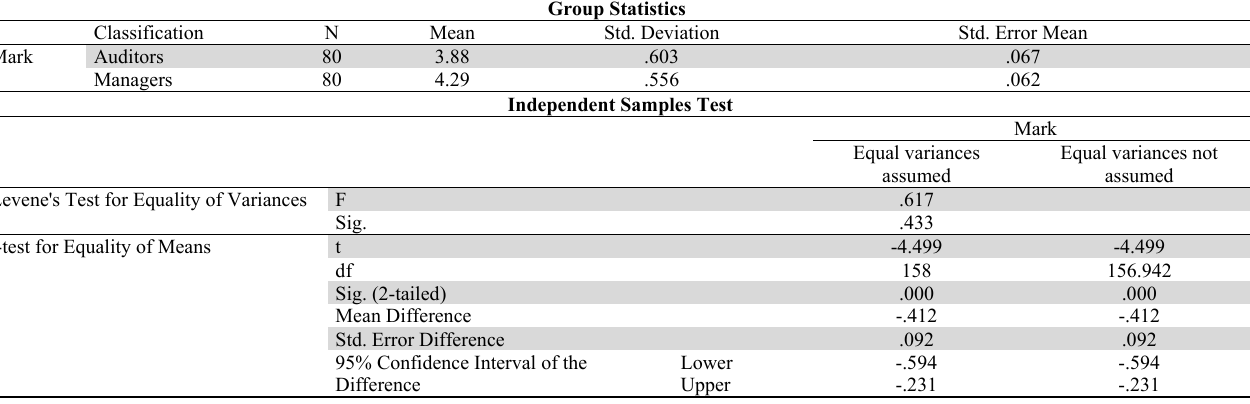
Evaluation of the impact of the tax policy on the application of the international financial reporting standards for SMEs from the perspective of auditors and managers.